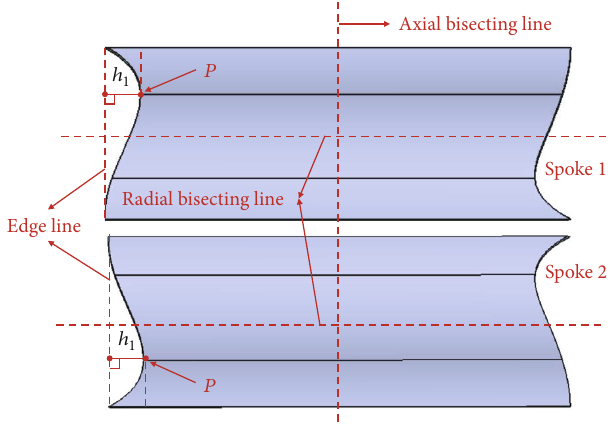
Figure 11: Bionic modi fi ed design of spoke.